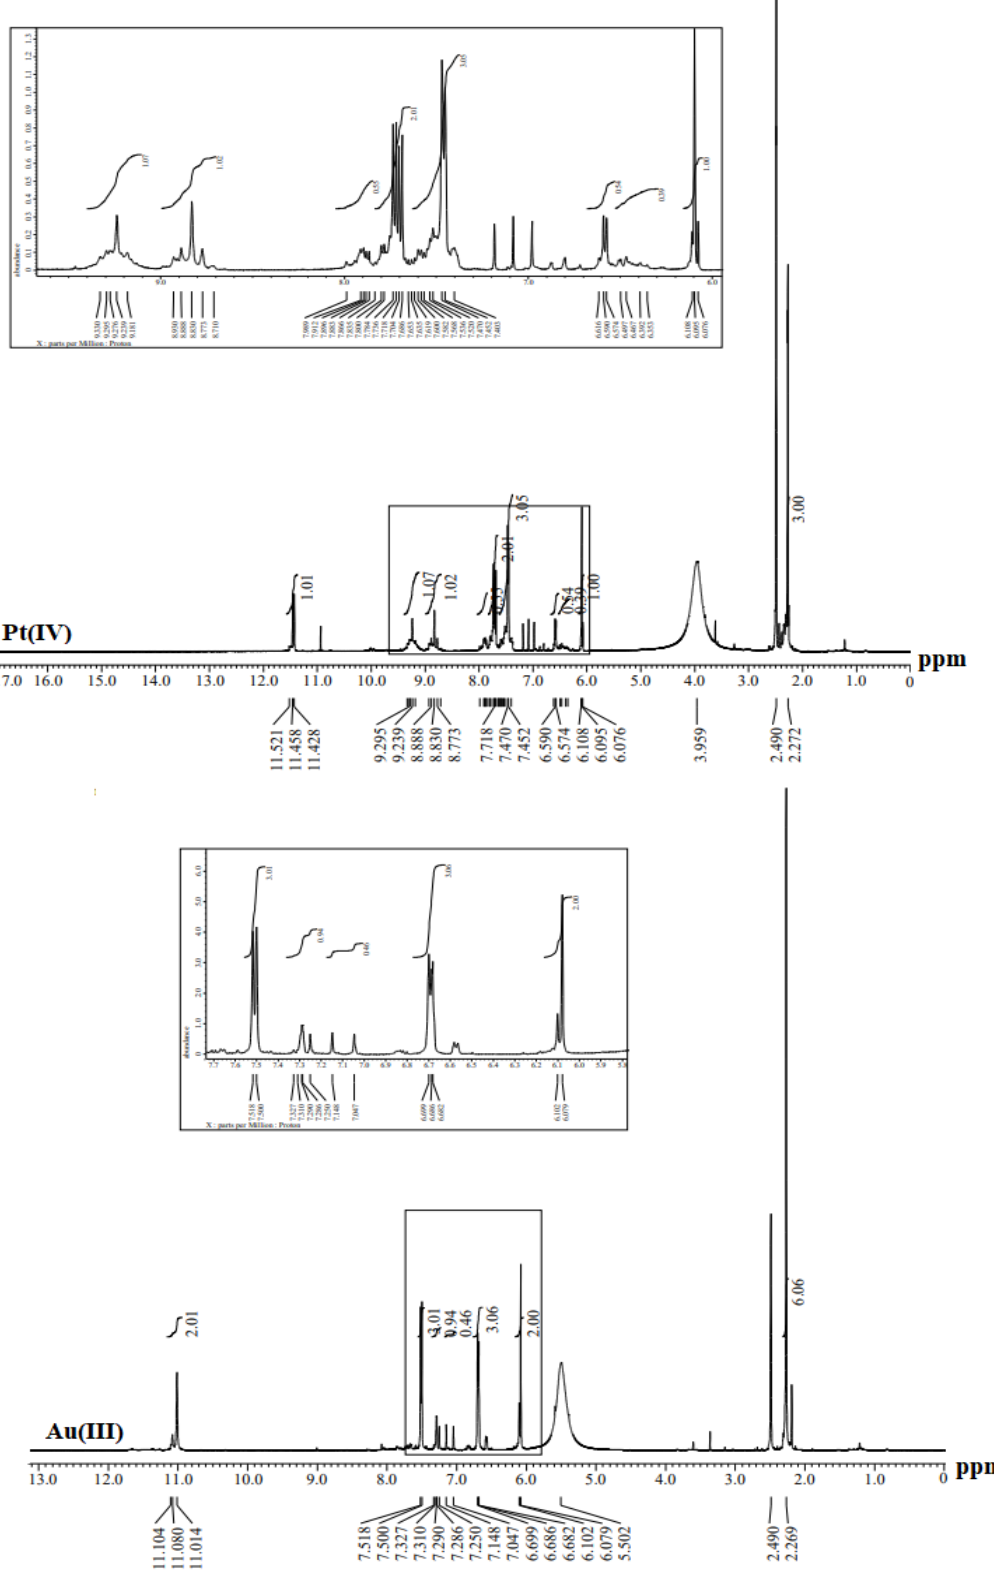
Figure 2. 1 H NMR spectrum for Au(III) and Pt(IV), complexes.